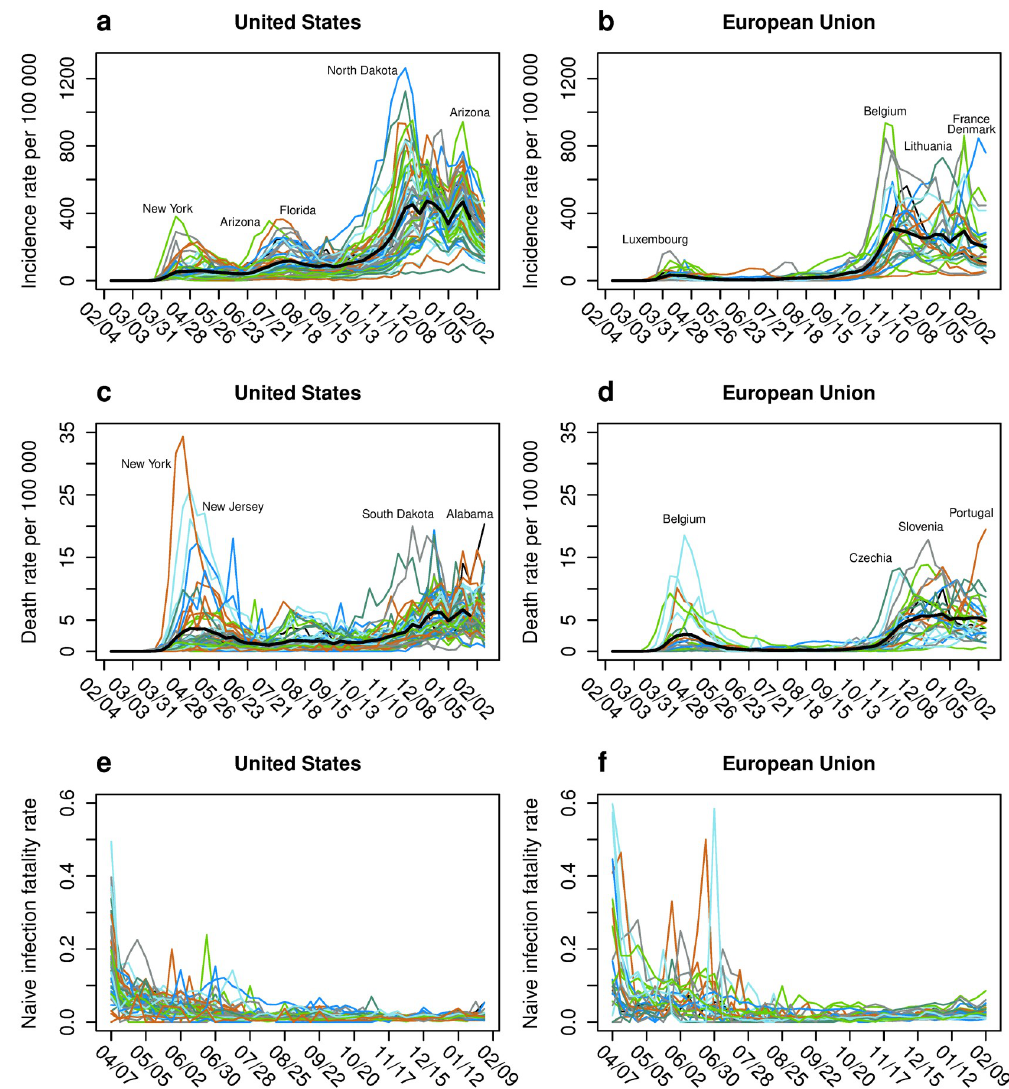
Fig 3. Infection, death and infection fatality rates for the United States and the European Union. Infection rate, death rate and naive infection fatality rate (nIFR) for the states of the United States (left column) and the member states of the European Union (right column). Panels a and b show the infection rate per 100,000 population over 7 days, panels c and d the death rate per 100 000 population over 7 days and panels e and f the time course of the nIFR. The horizontal axis shows the time between February 2020 and February 2021. The black thick lines show the mean incidence and death rate across all